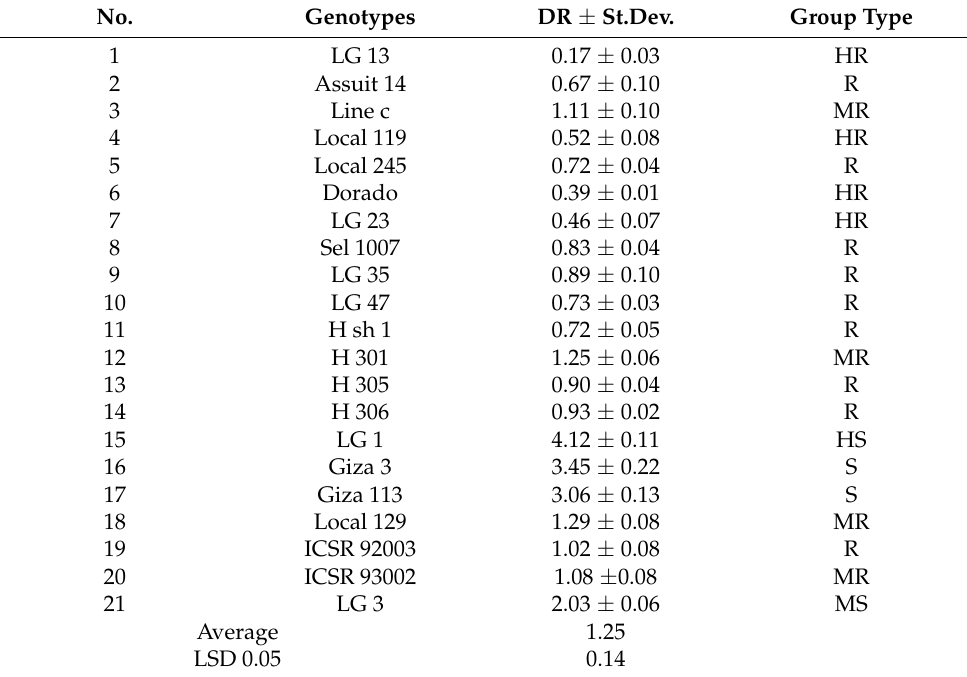
Table 3. Reaction of twenty-one grain sorghum genotypes for acremonium wilt disease during season 2019.